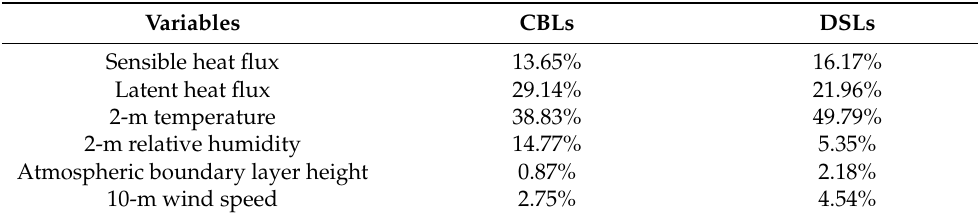
Table 3. Contributions of different factors affected by the underlying surface of “water networks” to the change of PM 2.5 concentrations. Variables CBLs DSLs Sensible heat flux 13.65% 16.17% Latent heat flux 29.14% 21.96% 2-m temperature 38.83% 49.79% 2-m relative humidity 14.77% 5.35% Atmospheric boundary layer height 0.87%